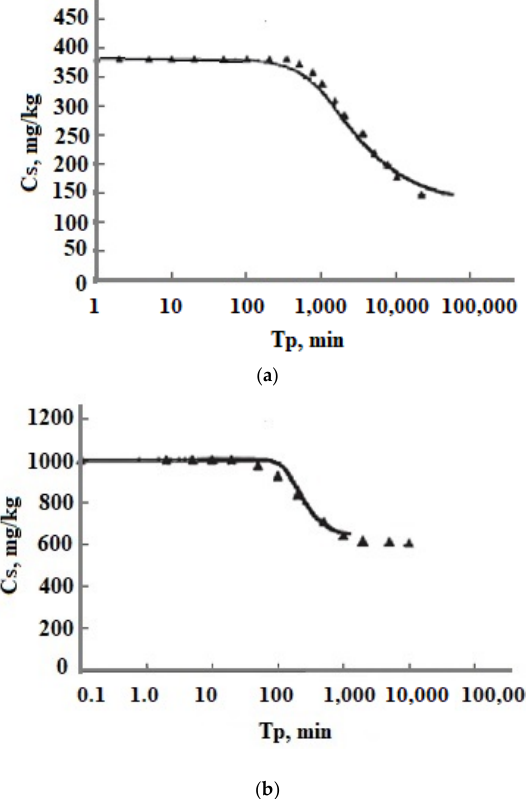
Figure 11. Comparing the experimental data [19] with the results of the numerical simulation. ( a ) t = 30 °C, C s = 383 mg/kg, рН 7.0; ( b ) t = 150 °C, C s = 1008 mg/kg, рН 7.85. I s = 0.000132–0.00134 mol/kg. ▬ —results of the simulation; ▲ —experimental data.